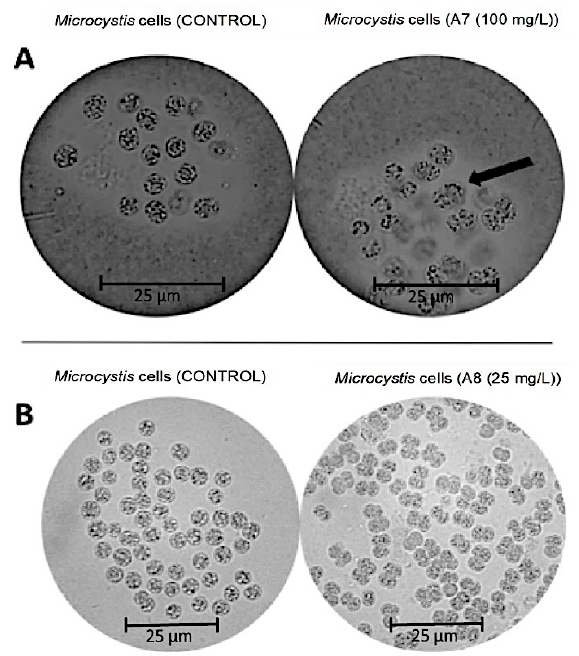
Figure 3. Aspects of M. aeruginosa Kützing cells under an optical microscope (40x) after treatment with vanillin ( A ) and eugenol ( B ) for 72 h. Scale bar: 25 µ m.